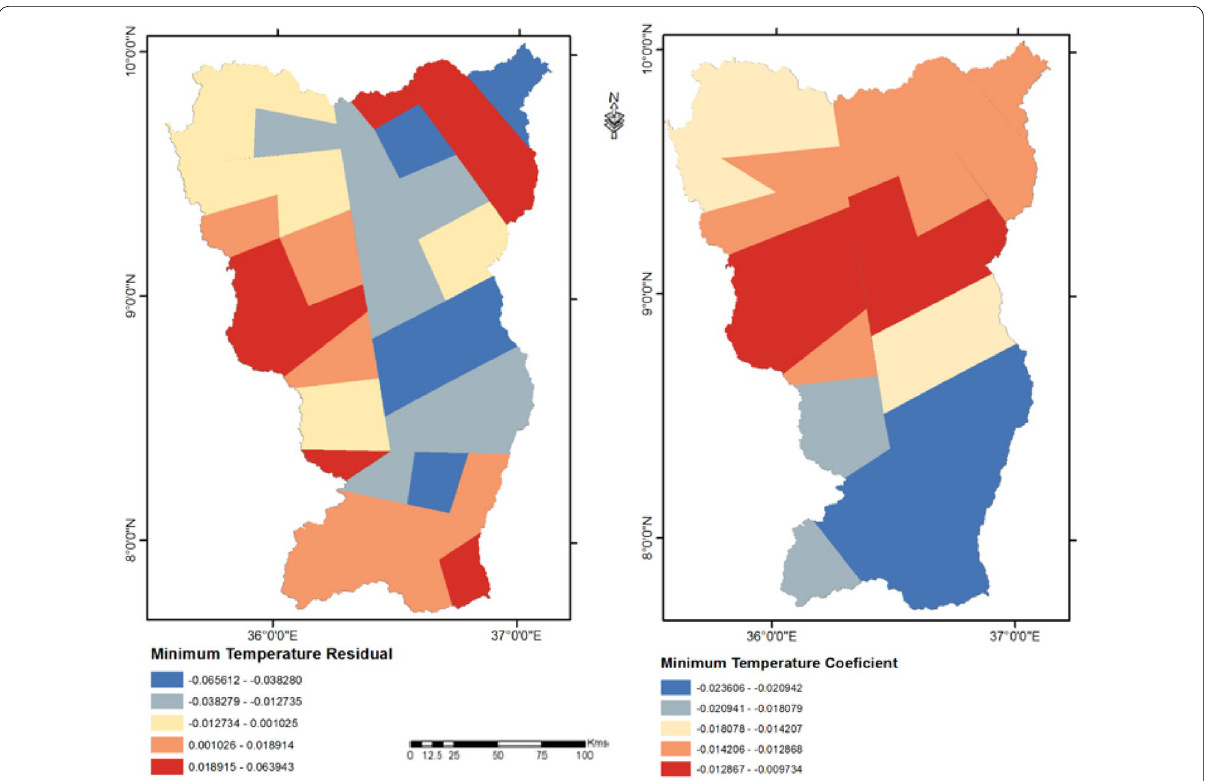
Fig. 7 GWR model residuals (right) and coefficients (left) for NDVI-minimum